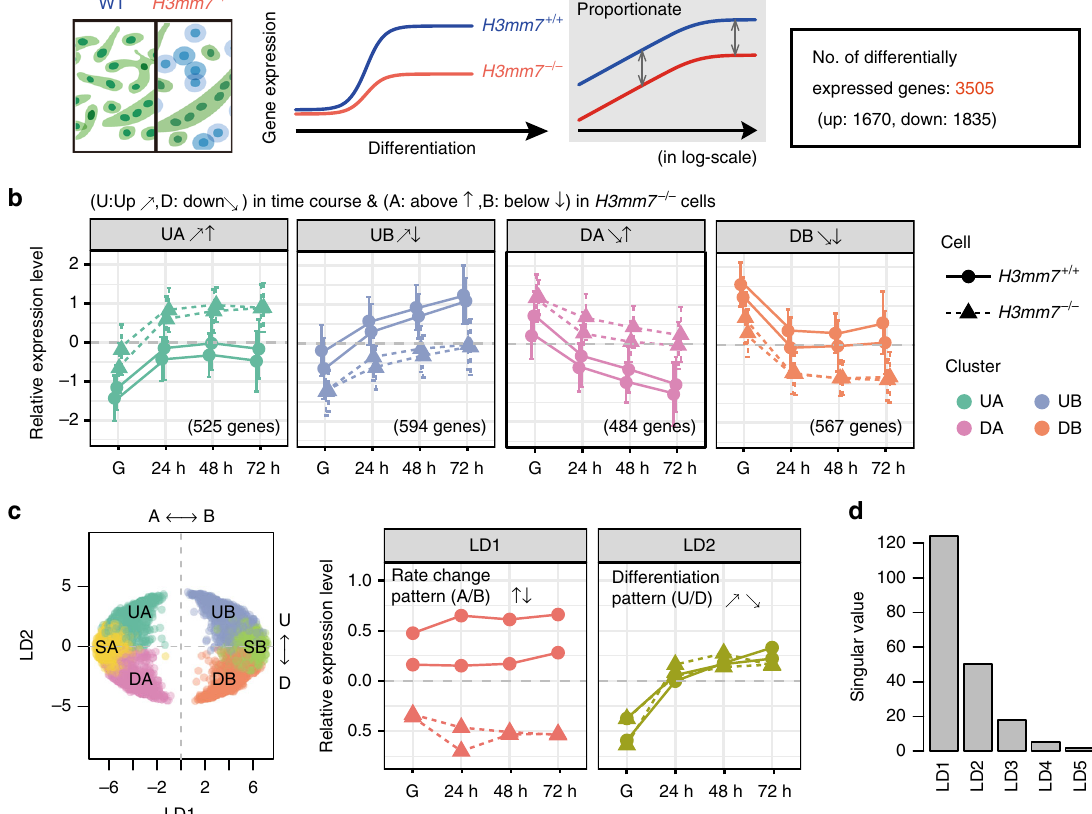
Fig. 2 H3mm7 − / − causes the rate change of gene expression during differentiation. a For all DEGs, the rate change of gene expression was observed throughout the differentiation time course. The illustrations explain the result of the statistical test against RNA-seq data. b The four types of rate changing patterns during differentiation are explained by the combination of the patterns: Up/Down in time and Above/Below in H3mm7 − / − cells. The points indicate the cluster average of the relative (gene-wise Z -normalized) expression levels of two cell types ( H3mm7 + / + and H3mm7 − / − ) with two replicates. The error bars indicate ± 1 SD. The numbers of the genes in the clusters are indicated in parentheses. c LDA extracted two major gene expression patterns during differentiation that correspond to A/B and U/D. The points indicate the genes of the clusters in LD space spanned by LD1 (middle) and LD2 (right) components. d The singular values of the LDA (the ratio of between- and within-cluster standard deviations) indicate that the two most relevant components to discriminate the clusters were LD1 (A/B) and LD2